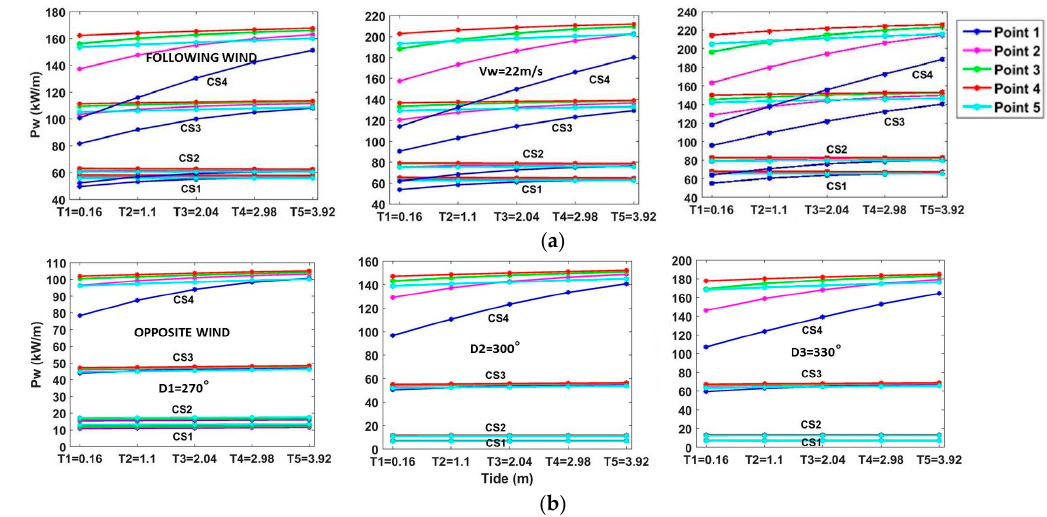
Figure 15. High wind conditions ( V w = 22 m/s): P w variations along the reference points corresponding to the three different directions of the incoming waves (D1, D2, D3) and to the five tide conditions (T1, T2, T3, T4, and T5) for all the case studies considered (CS1, CS2, CS3, CS4): ( a ) following wind; and ( b ) opposite wind.